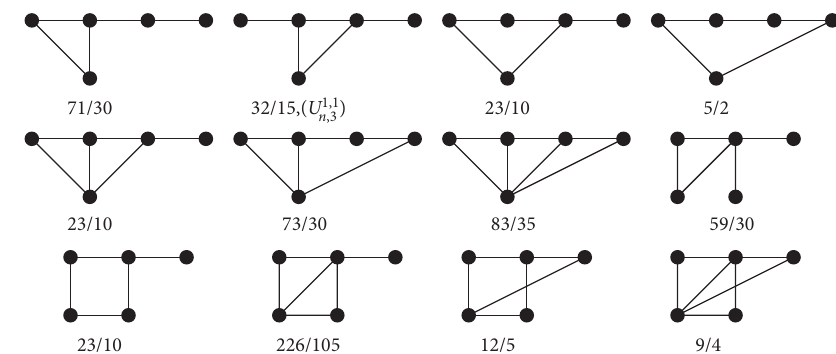
Figure 3: Quasi-tree graphs of order 5 and their harmonic indices.